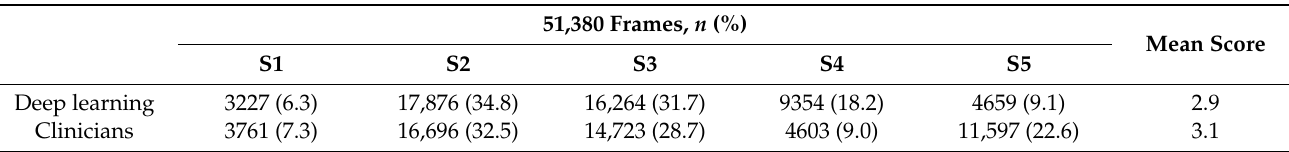
Table 2. The performance of deep learning algorithm calculating small bowel cleansing score, agreement with clinician’s